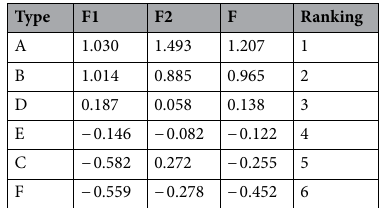
Table 8. Ranking of crack